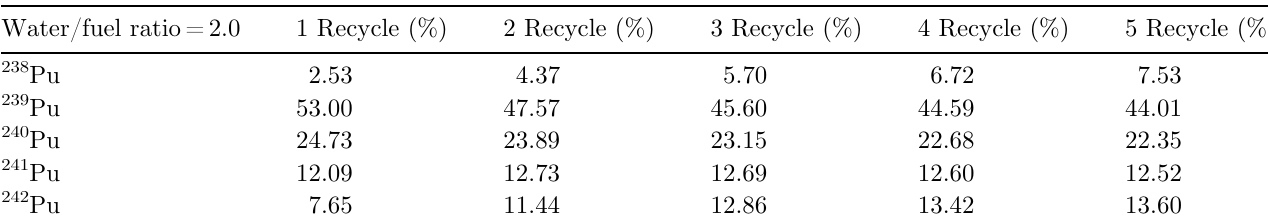
Table 5. Plutonium isotopic composition for FA with water/fuel ratio = 2.0. Water/fuel ratio = 2.0